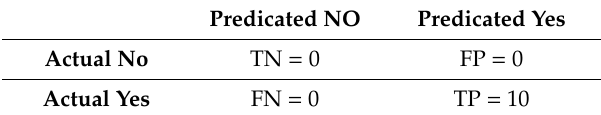
Table 10. Confusion matrix of dirt